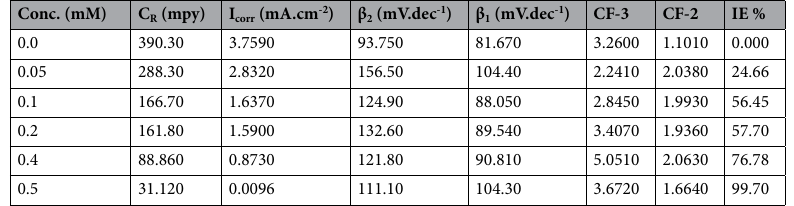
Table 7. Electrochemical frequency modulation (EFM) parameters for MS in 1.0 M HCl with different concentrations of nonanedihydrazide at 303 K.